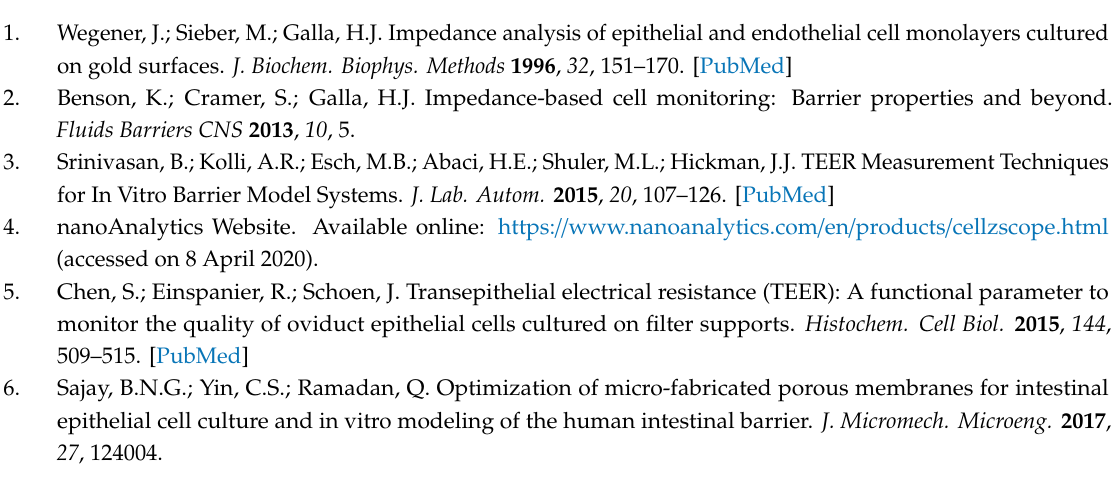
Table S3: The fitting equation parameters for the data corresponding to the TEER variations during exposure to acidic media shown in Figure 5b, fitted using a 4th order polynomial. Table S4: The fitting equation parameters for the data corresponding to the TEER variations during exposure to basic media shown in Figure 5b. Table S5: The fitting equation parameters for the data corresponding to the TEER variations after exposure to acidic media shown in Figure 5b, fitted using a log normal function. Table S6: The fitting equation parameters for the data corresponding to the TEER variations after exposure to basic media shown in Figure 5b. Table S7: The fitting equation parameters for the data corresponding to the variations of on-chip TEER responses of tissues exposed to acidic solution with pH 1, with or without sodium alginate treatment, shown in Figure 5c, fitted using a 4th order polynomial. Table S8: The fitting equation parameters obtained for the linear fit of the normalized TEER variation shown in Figure 5d. Table S9: The fitting equation parameters obtained for the parabolic fit of the relative permeability data shown in Figure 5d. Table S10: The numerical values for the data plotted in Figure 3a,b. Table S11: The numerical values for the data plotted in Figure 5a,d. Table S12: The numerical values for the data plotted in Figure